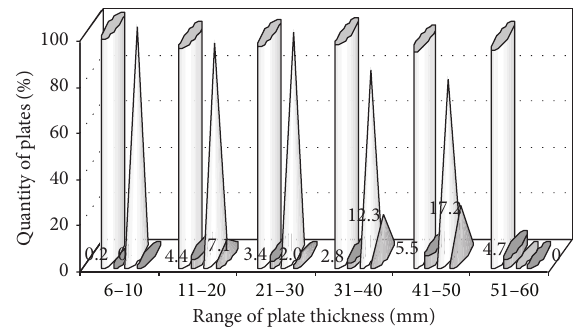
Figure 14: The division of test plates according to accepted criteria: grade 𝑆 0 (cylinders) and grade 𝑆 2 (cones), accepted (light) and defective (dark, 0–17.2%)